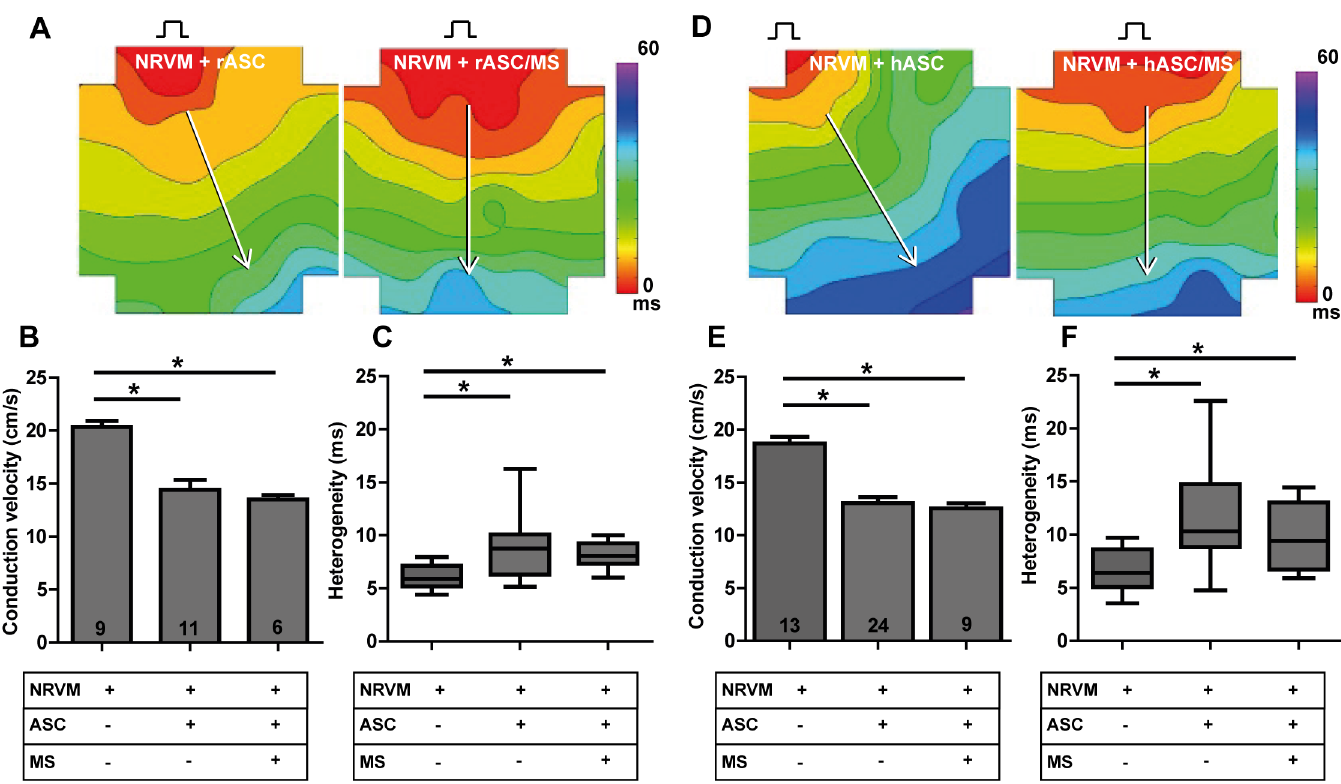
Fig 9. Influence of recombinant human collagen-based microspheres on conduction slowing mediated by a contact based mechanism. Activation maps of A: monolayers of NRVM cultured with rASC and rASC loadedmicrospheres, respectively. The effect on conductionvelocity ( B ) and conduction heterogeneity ( C ) are determinedalong the white arrows perpendicular to isochronal (black) lines. Activation maps of D : monolayers of NRVM cultured with hASC and hASC loadedmicrospheres, respectively. The effect on conductionvelocity ( E ) and conductionheterogeneity ( F ) are determined along the white arrows perpendicular to isochronal(black) lines. * indicatesp < 0.001 comparedto the monolayers of NRVM. Number of replicates per experimental condition is indicatedin the bar-graphs. Abbreviations; hASC: humanadiposetissue-derived stromal cells, MS: microspheres, NRVM: neonatalrat ventricular myocytes, and rASC: rat adiposetissue-derived stromal